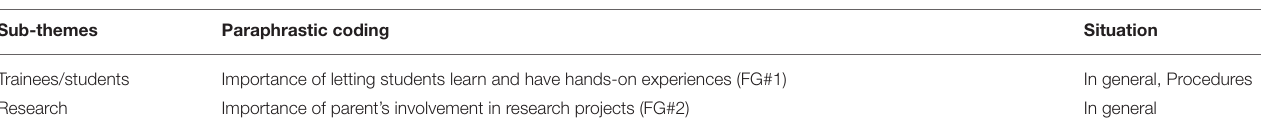
TABLE 9 | Academic and research